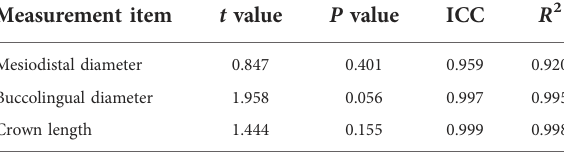
TABLE 3 Results of paired t -test, consistency analysis, and regression analysis for each measurement item of 50 maxillary fi rst premolars by manual and CBCT image measurement.